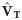
Effects of lowest PaO2/FIO2 ratio on standardized tidal volume (V^T) and ARDS documentation in ARDS and control cohorts.Top panels show patients with ARDS documented in their chart (purple diamonds) and non-documented patients (tan circles). Gray areas indicate LTVV range from current guidelines[7], with dashed line at 6.5 mL/kg PBW from currently recommended threshold. Solid lines show linear (V^T) and logistic (documentation) fits for scatter plot data (shaded regions, 95% confidence bands). Reported beta coefficients are for standardized inputs. * p < 0.0003, ** p < 0.0005.